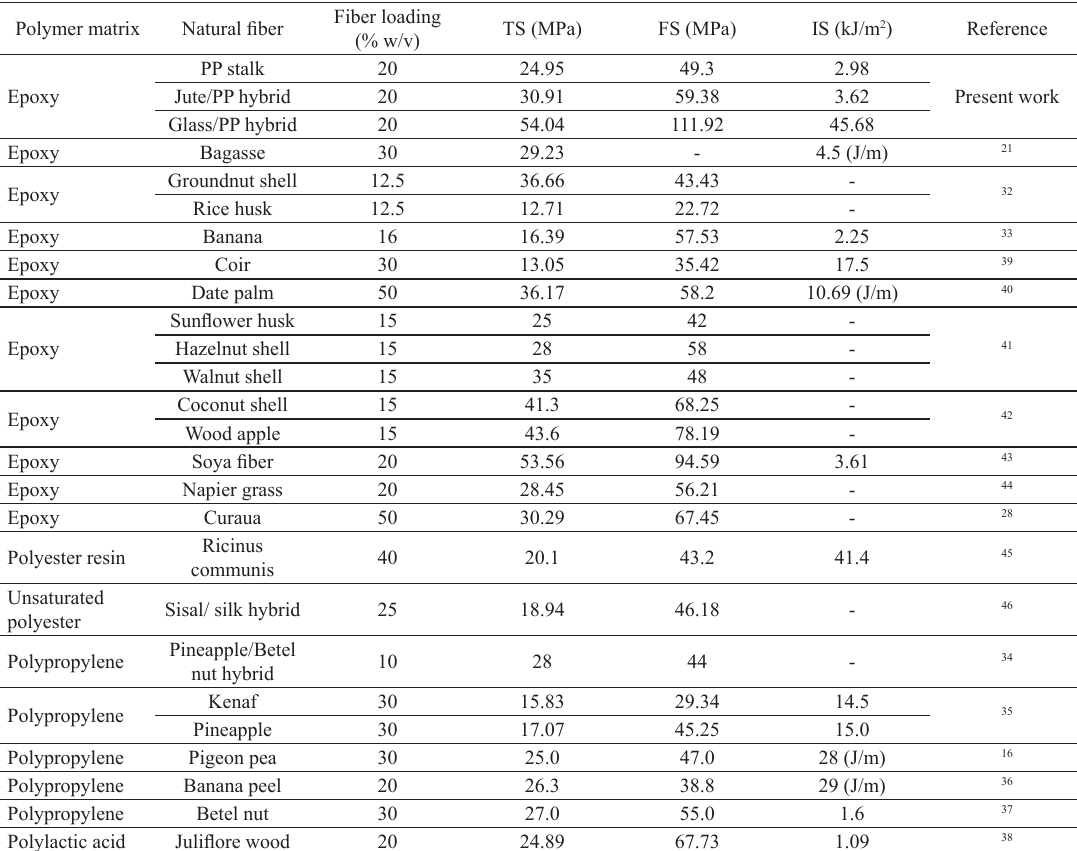
Table 7. Comparative assessment of mechanical properties of PP stalk fiber-reinforced composites with other natural fiber-reinforced composites. Polymer